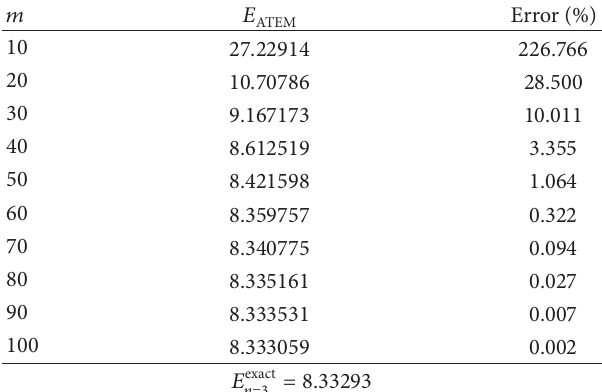
Table 1: Comparison of third excited state eigenvalue of the quartic potential in (9) by means of ATEM for 𝛾 = 2 , 𝑎 = 2 , and 𝑏 = 1 and selection of optimum value for iteration number 𝑚 due to percent error